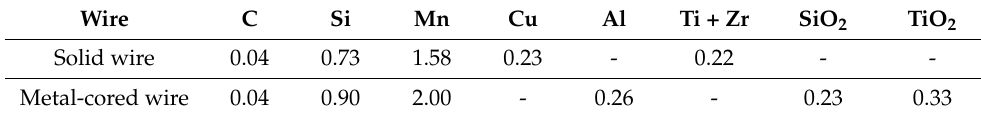
Table 1. Chemical composition (mass%) of investigated wires.